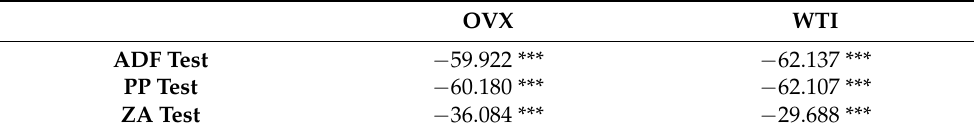
Table 3. Results for conventional unit root tests for the two